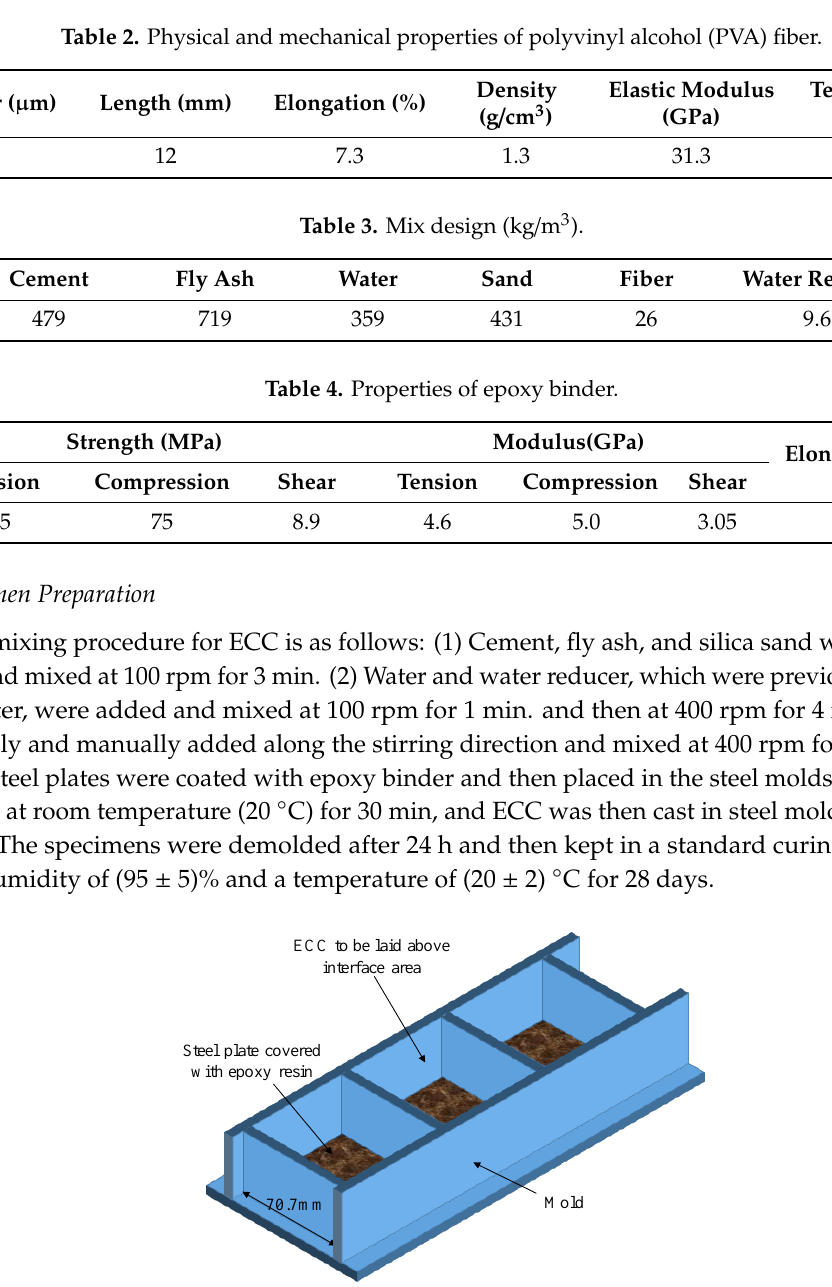
Figure 2. Preparation of wet-bonding specimens.